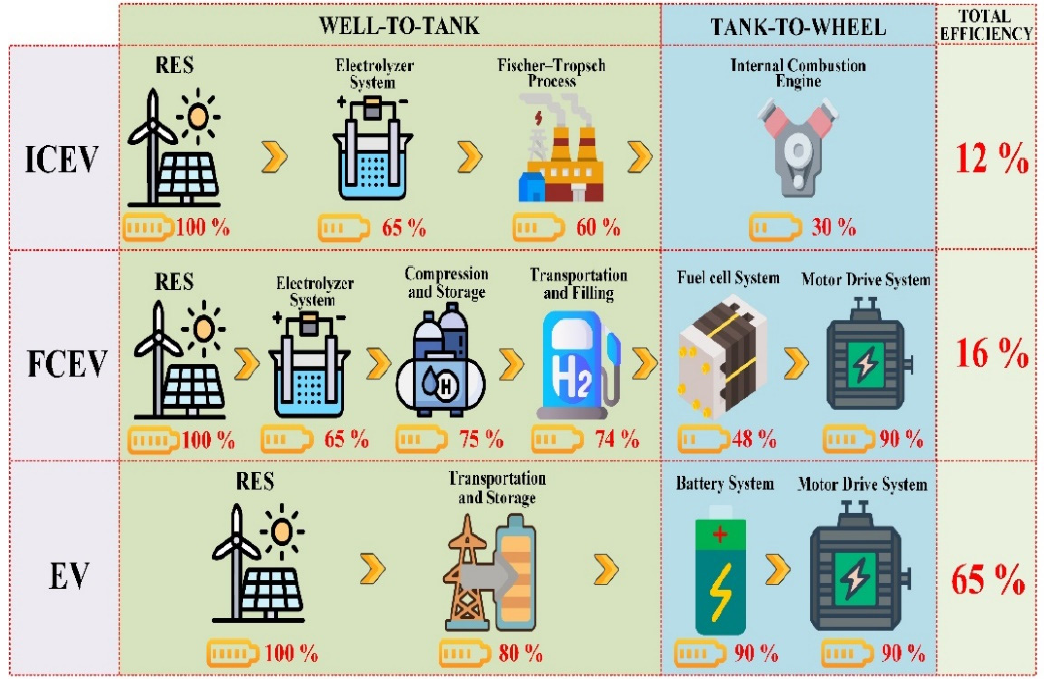
Figure 8. Overview of energy conversion efficiency for different types of vehicles.